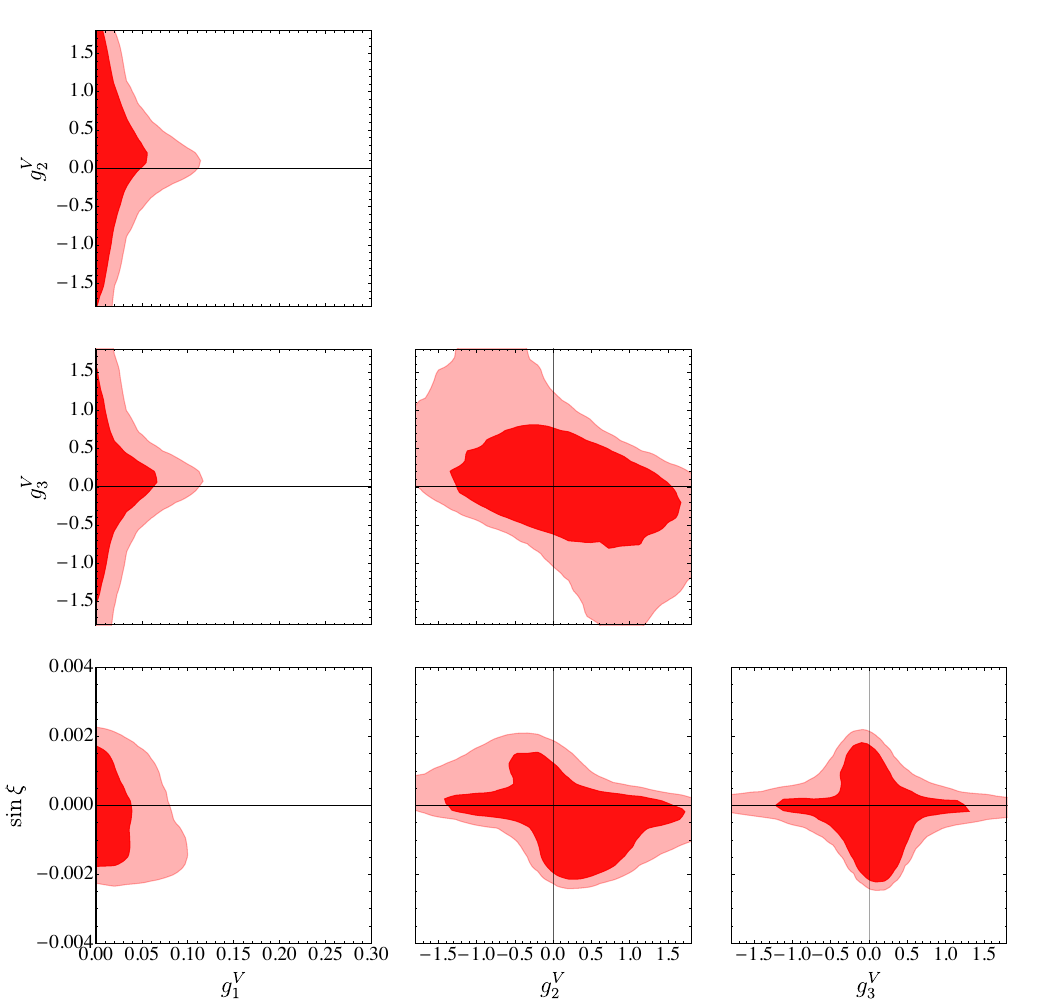
= g R = g V ii ii i